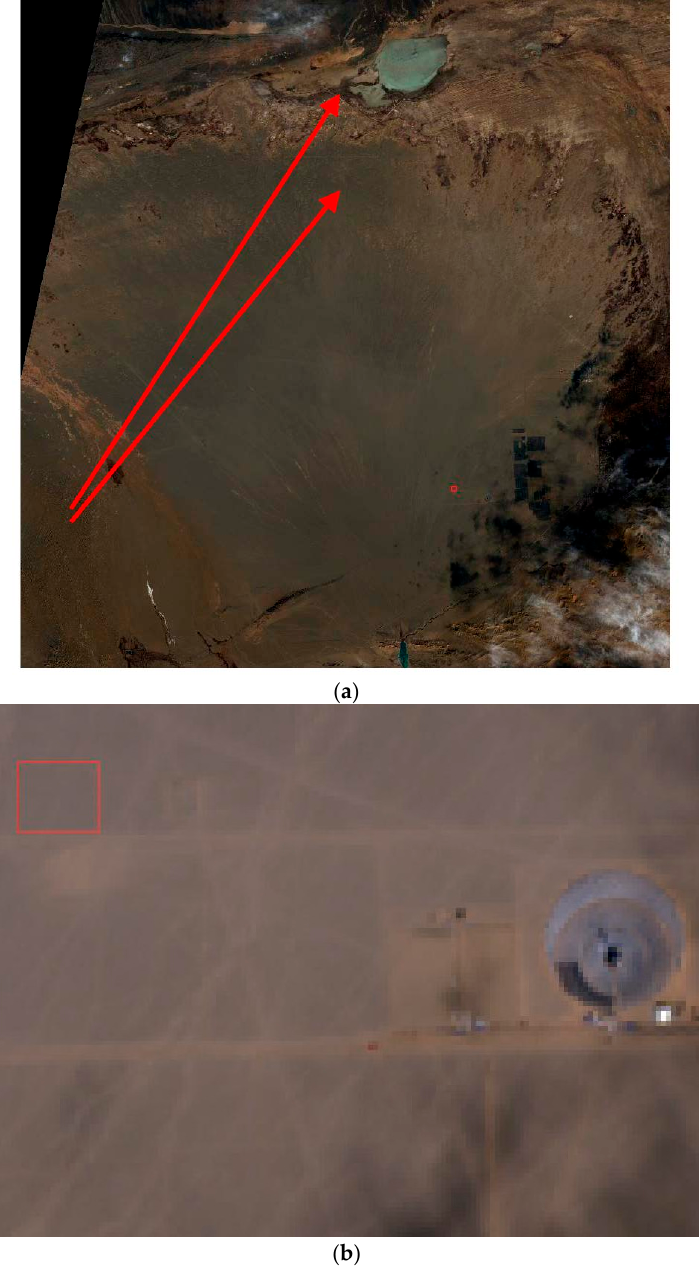
Figure 4. Dunhuang calibration site for medium-high resolution satellites, as illustrated in a Landsat 8/OLI image acquired on 2 February 2017. ( a ) Scaled subset image. ( b ) 5× magnification of a portion of the original image, where the red rectangle is the outline of the calibration site.